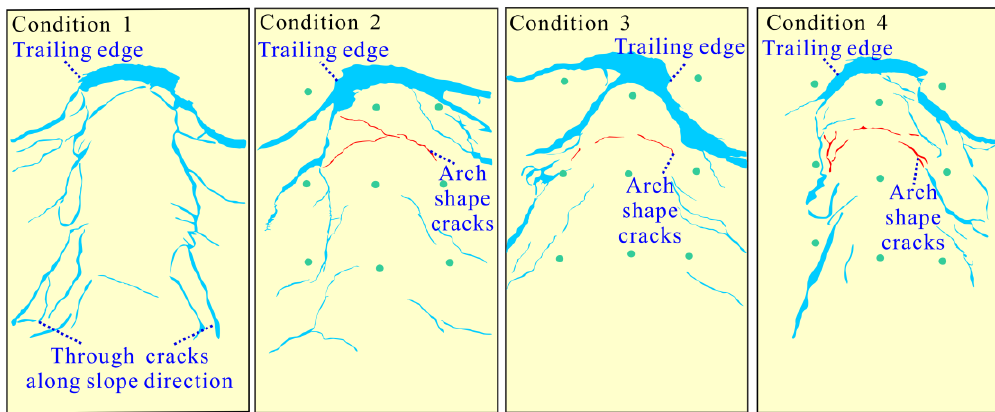
Figure 14. Cracks at 2520s of the four conditions.